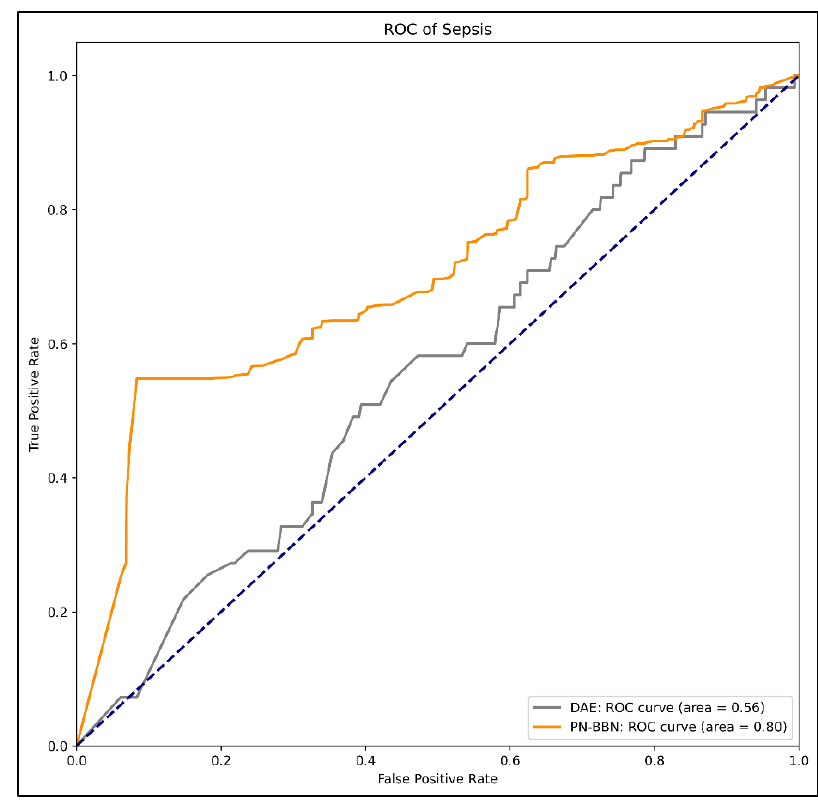
Figure 14. ROC of